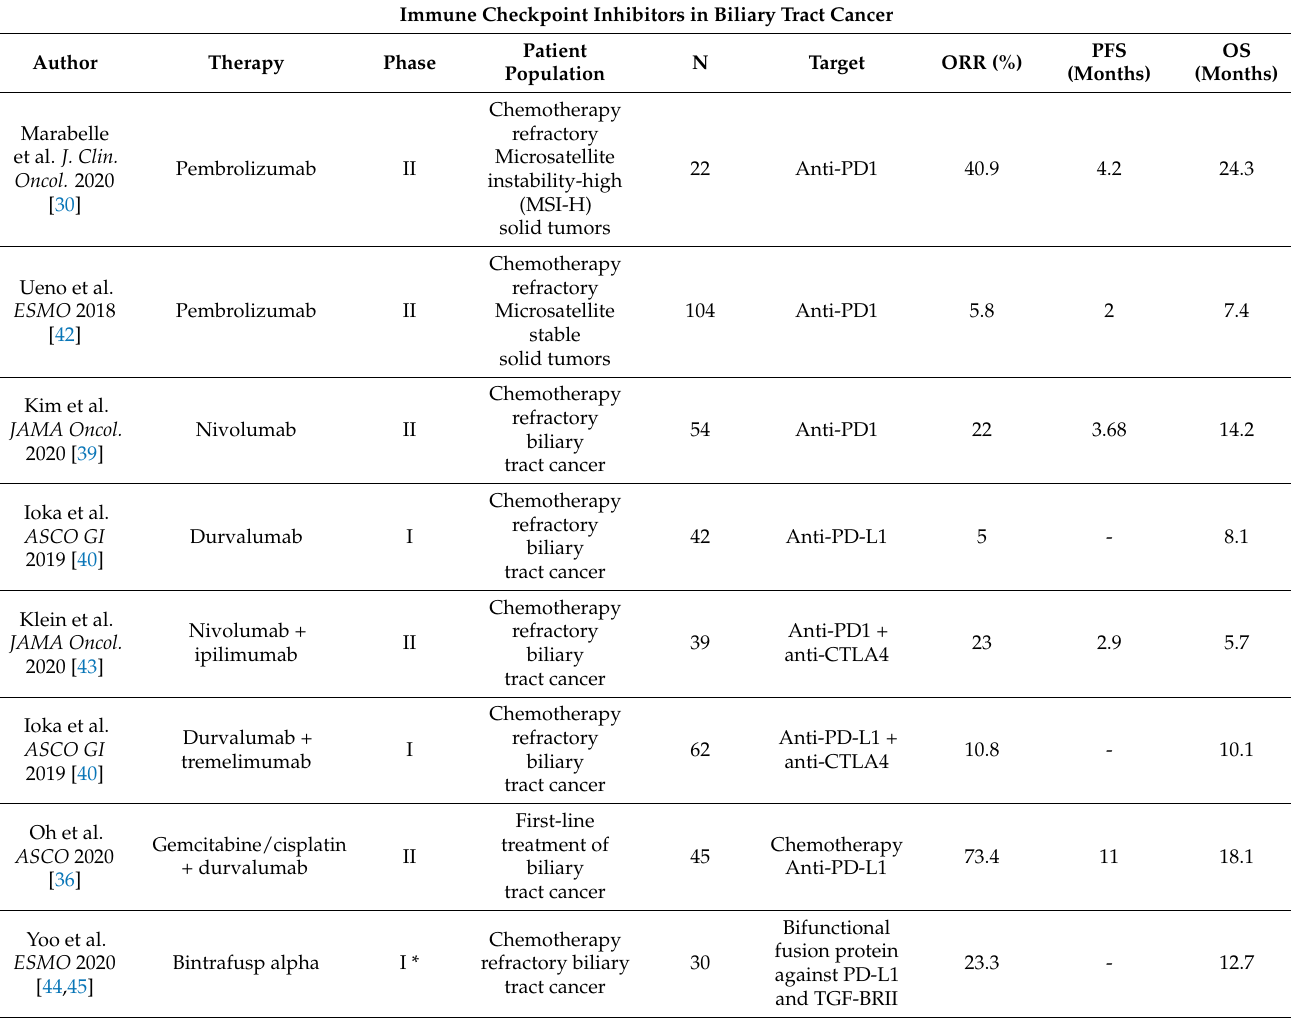
Table 1. Immune checkpoint Inhibitors in biliary tract